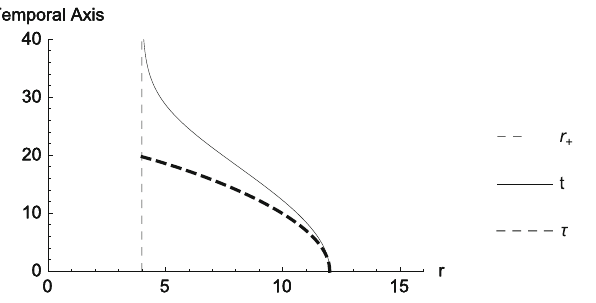
Fig. 2 The behavior of the proper ( τ ) and the coordinate ( t ) time as a function of r , with z = 100, R 0 = 12, and V ( R 0 ) = 0 . 719